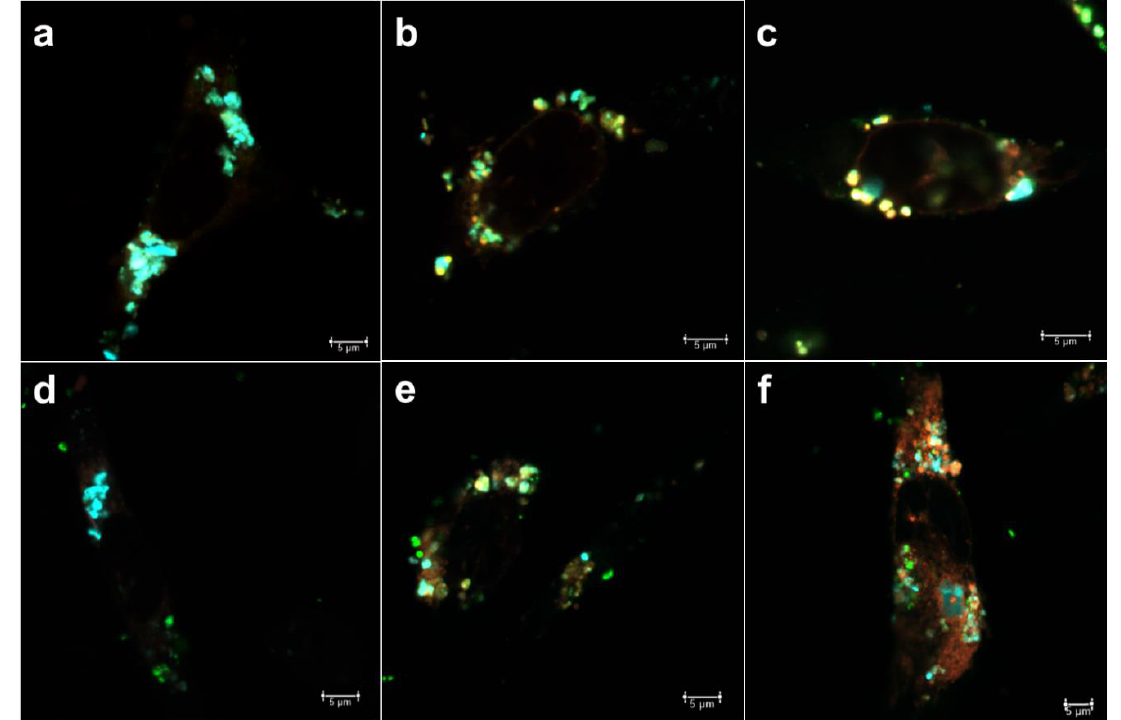
Figure 3. MSNs (cyan) loaded with fluorescent dye (DiD) (red) and endosomal markers (green) ( a – c ) early endosomal antigen-1 (EEA1) (0.1, 0.5, 1.0 wt % loading of DiD, respectively) and ( d – f ) Rab7 (0.1, 0.5, 1.0 wt % loading of DiD, respectively) at 24 h.